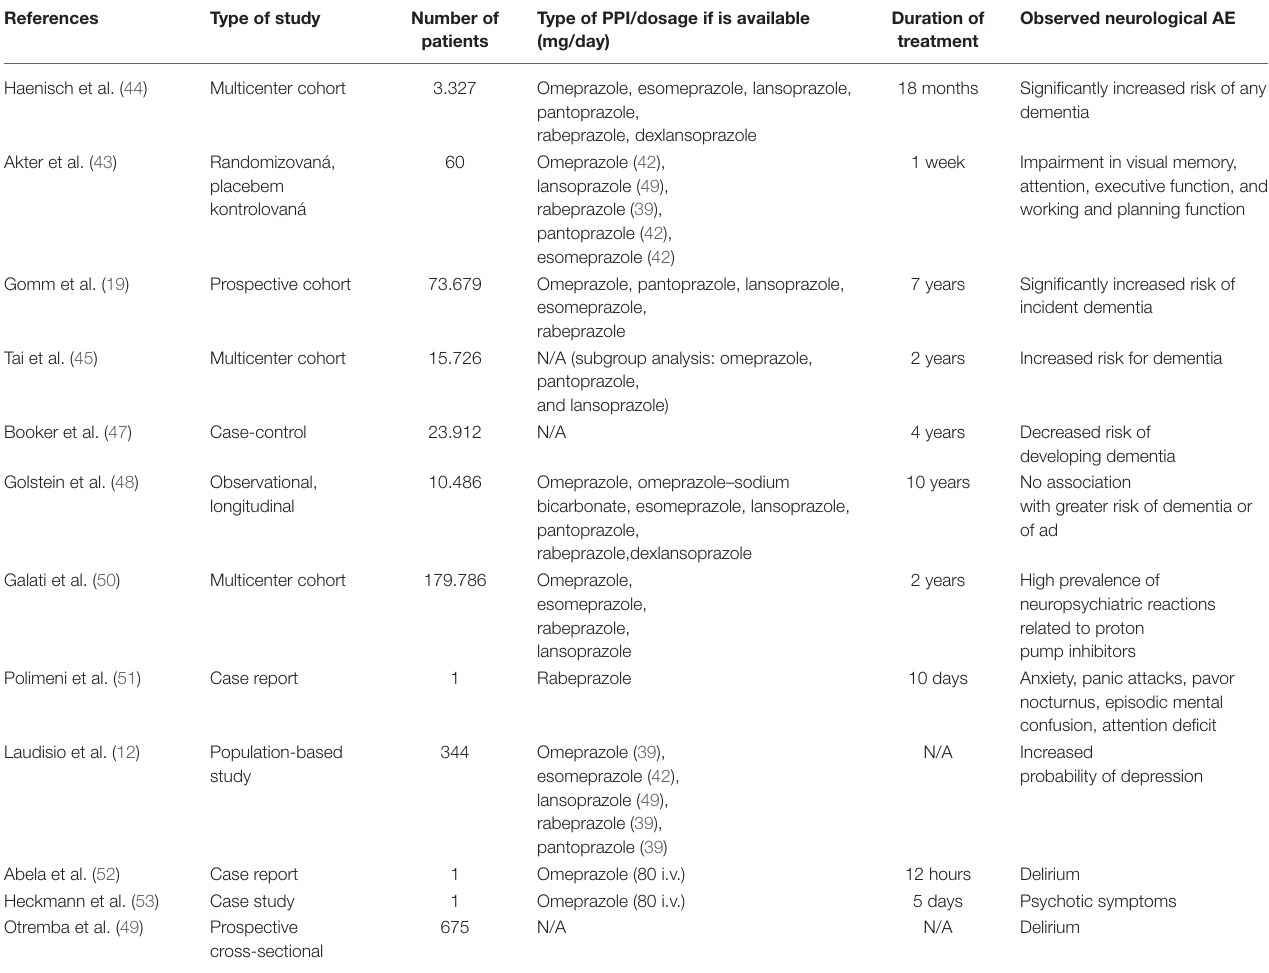
TABLE 4 | Overview and specifications of individual clinical trials evaluating the effect of PPI on the potential development of neurological adverse